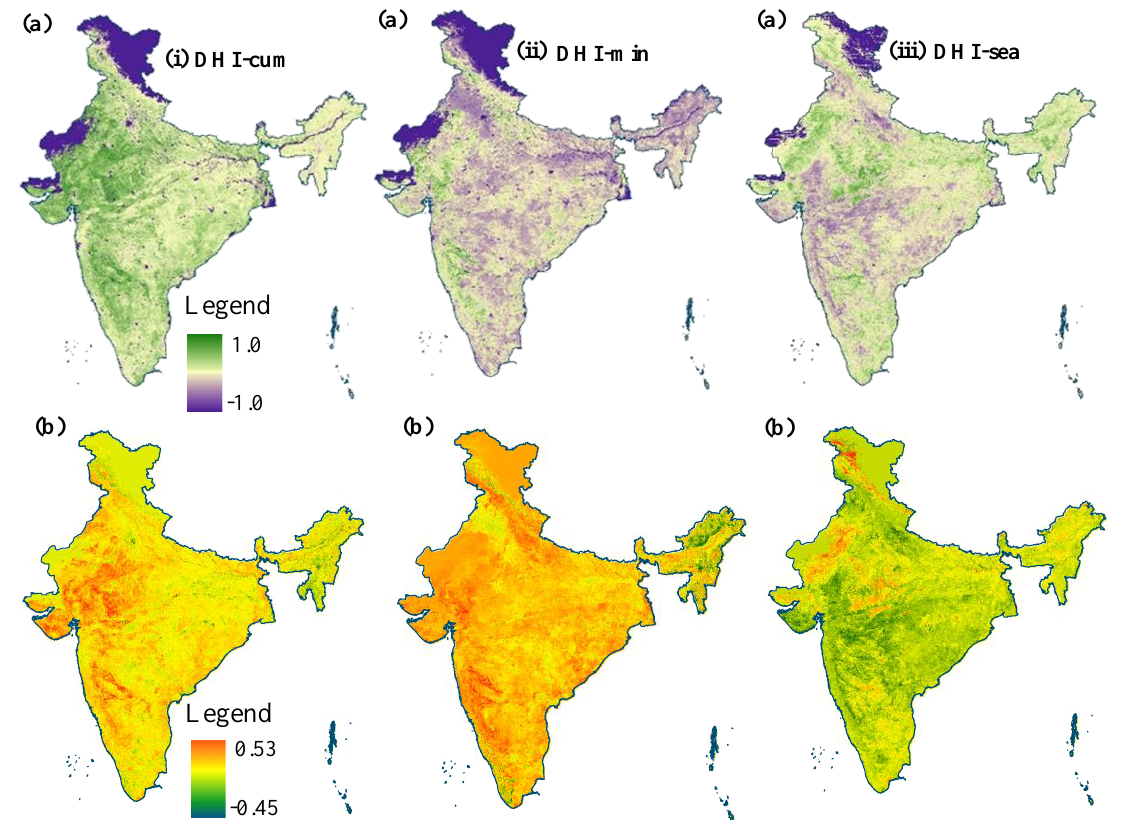
Figure 6. The inter-year (2001–2015) correlation coefficient and regression coefficient calculated for each DHI components are shown as: ( i ) DHI-cum ( a , b ); ( ii ) DHI-min ( a , b ); ( iii ) DHI-sea ( a , b ), respectively.